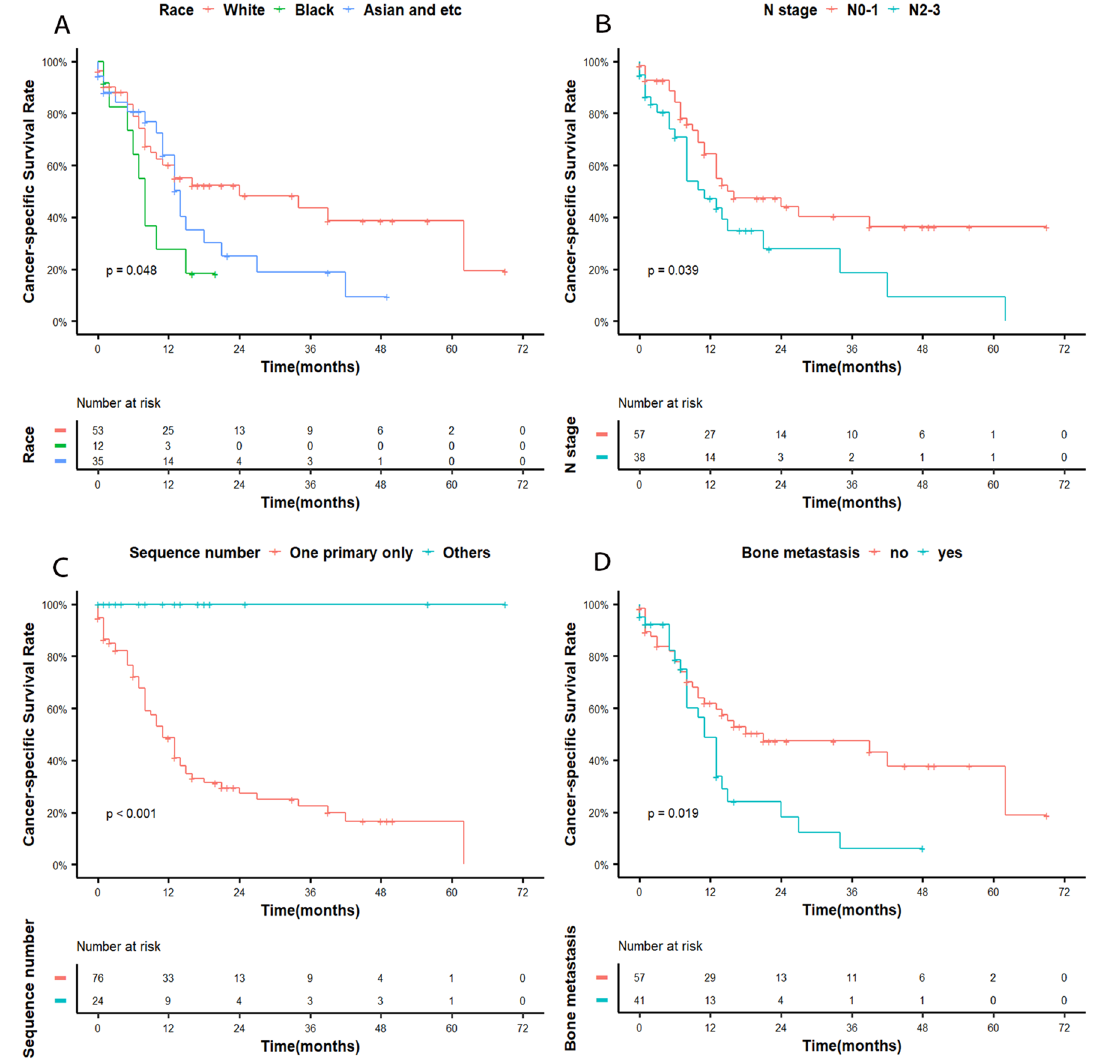
Figure 3. Kaplan–Meier curves are shown. ( A ) Race, ( B ) N stage, ( C ) sequence number, and ( D ) bone metastasis on associated with poorer OS (20.4 vs. 37.9 months; HR: 2.41, 95% CI: 1.72–3.38, p < 0.001) 27 . ShaSha He et al. also found that vertebral metastasis was an independent prognostic factor (HR: 1.997, 95% CI: 1.321–3.020, p = 0.001) in endemic patients 28 . Based on the abovementioned results, elderly patients with metastatic NPC may have three or more bone metastases or spinal metastases in nonendemic areas. This is probably why the results of our study are different from those of previous population studies. However, Qu Weiling’s study obtained opposite results, and meaningful results regarding CSS were obtained using a log-rank test for both liver and metastases 29 . Beyond these sites, other metastatic sites and the number of metastatic organs may significantly affect survival. However, no statistically significant conclusions were obtained using Cox regression multivariate analyses for lymph node, liver, brain, and lung metastases and the number of metastatic organs; this does not mean, though, that these factors have no effect on disease prognosis. A prospective randomized controlled trial found that the number of metastatic lesions and liver metastasis, not the number of metastatic locations, were independent prognostic factors of OS in patients with metastatic NPC 19 . The p value of the Kaplan–Meier curve for liver metastasis related to OS was approximately 0.05, and the two survival curves were clearly separated. This result implies that it is possible to obtain meaningful conclusions if the sample size is sufficient. The prognostic value of the number of organs with metastasis (single vs. multiple) is still controversial. The paper reported that single organ metastasis had a better prognosis than multiple organ metastasis 27 . Contrary to this finding, the number of organs with metastasis did not affect the prognosis, but the number of metastatic lesions did, and patients with multiple lesions had a worse prognosis than those with single lesions 16,19,30 . In our study, patients with single organ metastasis did not have better survival, which may be because they may exhibit more metastases within the organ. Jun Ma et al. noted that the size of the lung metastases was an independent prognostic factor for sur- vival in endemic patients 31 . In contrast, Yali reported that liver metastasis had adverse effects on survival, and